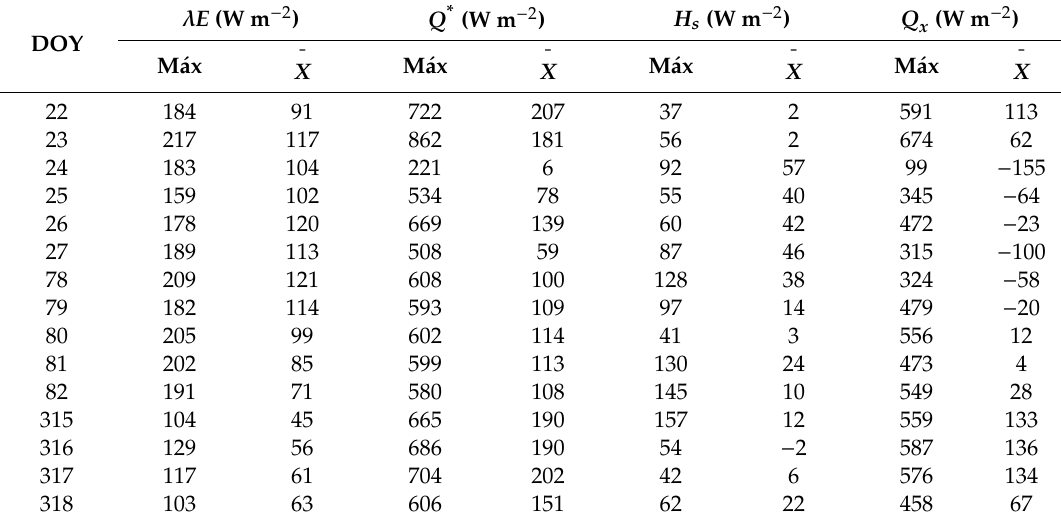
Figure 5. Surface energy budget components. Q ∗ is net radiation, Q x is water heat flux, H s is sensible heat flux and, λ E is the latent heat flux. Table 4. Daily maximum (Max) and mean ( 𝑋̅ ) values of the surface energy budget components.